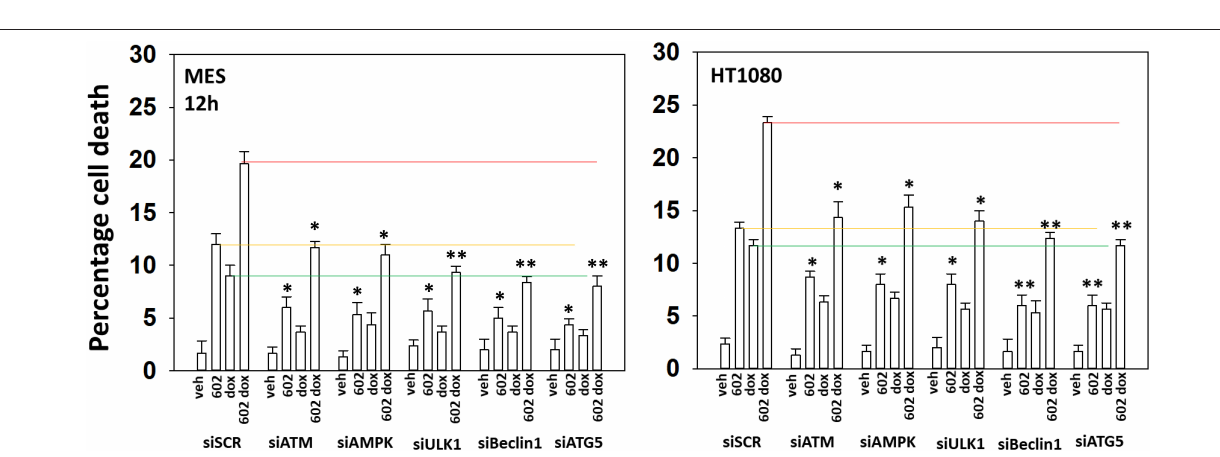
FIGURE 5 | GZ17-6.02 and doxorubicin individual and combination lethality is suppressed by knock down of ULK1, Beclin1, or ATG5. HT1080 and MES human sarcoma cells were transfected with a scrambled siRNA control (siSCR) or siRNA molecules to knock down the indicated proteins. Twenty-four hour afterwards, cells treated with vehicle control, GZ17-6.02 (2 µ M final curcumin), doxorubicin (200nM) or the drugs in combination for 12h. Cells were isolated, and viability determined by a trypan blue exclusion assay ( n = 3 + /–SD). * p < 0.05 less than vehicle control; ** p < 0.05 less than corresponding value in siATM or siAMPK α transfected cells. The red, yellow and green lines are included for purposes of comparison between the individual treatments and each of the specific